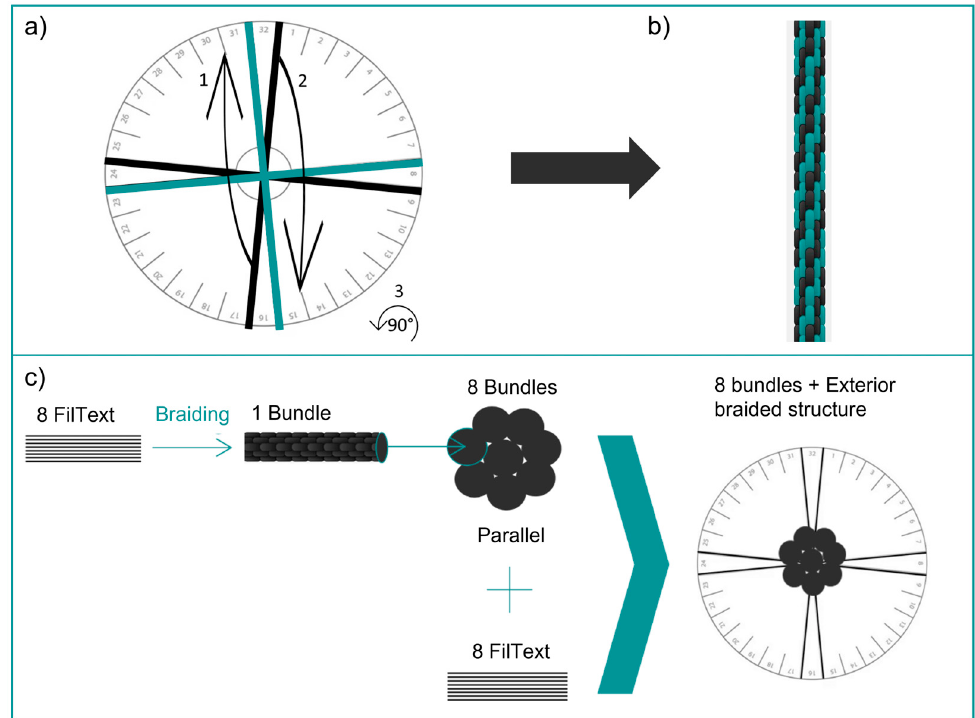
Figure 2. ( a ) Kumihimo technique: slot 32 of the disk is placed in the 12 o’clock position. Eight FilText filaments are tied together, placed in the center of the disk, and the loose ends loaded into slots 31 and 32, 7, and 8, 15 and 16, 23, and 24 on the kumihimo disk. Then, FilText filaments are moved from slot 16 to 30 (1) and 32 to 14 (2). Then, the disk is rotated 90 ° counterclockwise (3) and the FilText filaments moved from slot 24 to 6 and slot 8 to 22. This procedure was repeated until the required braid length was reached; ( b ) braided structure obtained after multiple repetitions of ( a ); ( c ) structure of the final braided